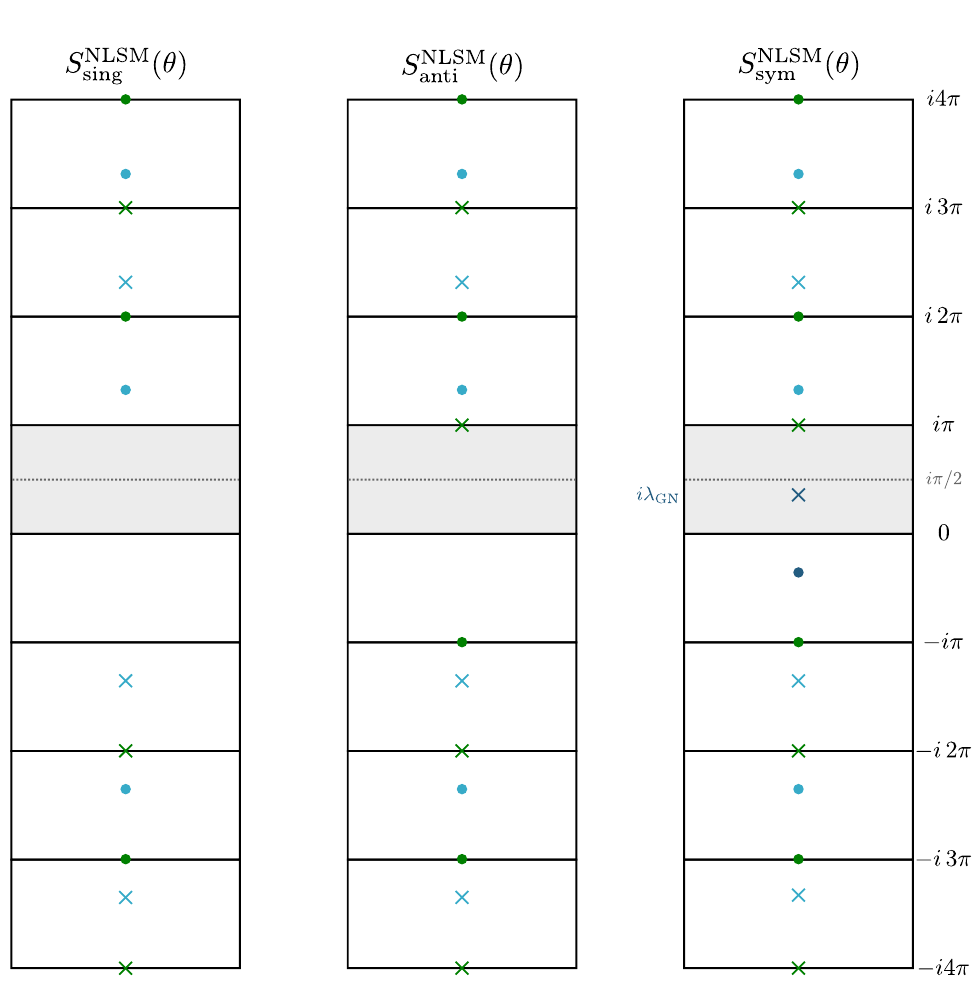
Figure 2 . Analytic structure of the non-linear sigma model S-matrix in the (cid:18) plane corresponding to the ‘minimal’ integrable solution. The physical strip is highlighted in grey. The bullets (cid:15) represent simple poles and the crosses (cid:2) simple zeros. There is a zero (cid:2) in the physical strip in the symmetric component at the position (cid:18) = i(cid:21) GN = 2 (cid:25)= ( N (cid:0) 2). Integrability implies that unitarity is saturated, i.e. S rep ( (cid:18) ) S rep ( (cid:0) (cid:18) ) = 1, so that in a given representation a pole at (cid:18) has an associated zero at (cid:0) (cid:18) . Crossing mixes the di(cid:11)erent representations relating points at (cid:18) and i(cid:25) (cid:0) (cid:18) (see discussion around